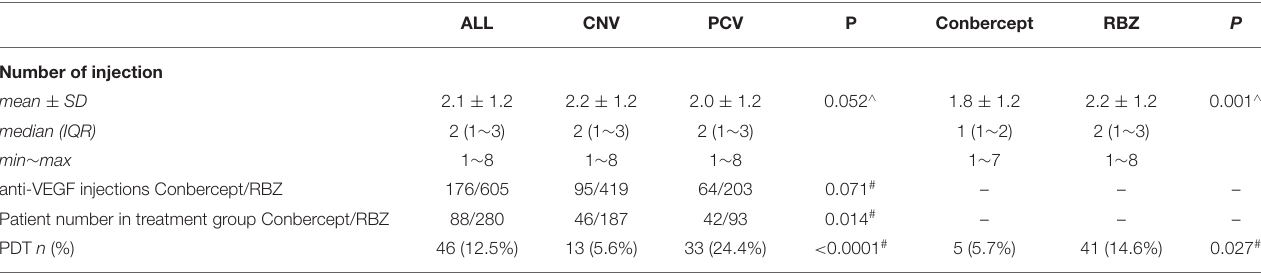
TABLE 2 | Number of injections of all